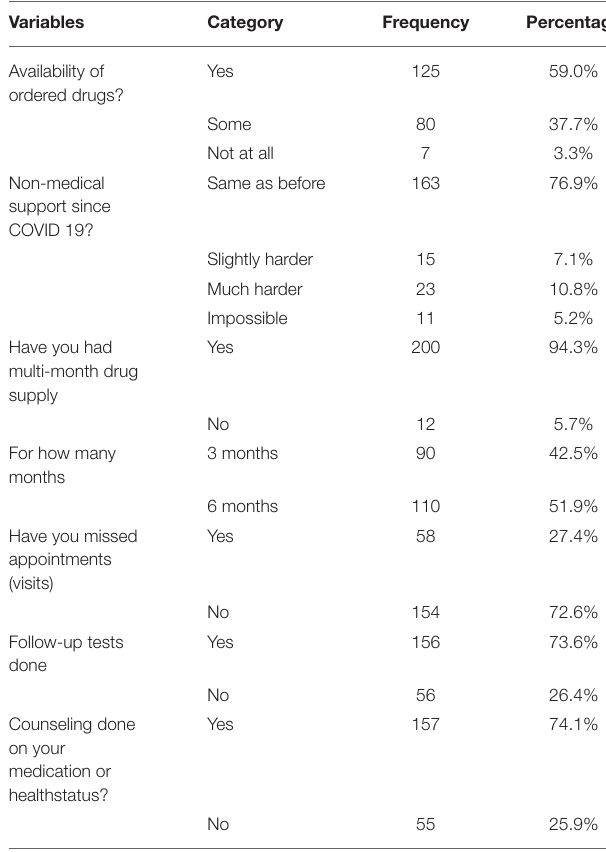
TABLE 7 | Response of the study participants to medications and follow-up, Addis Ababa, Ethiopia May,